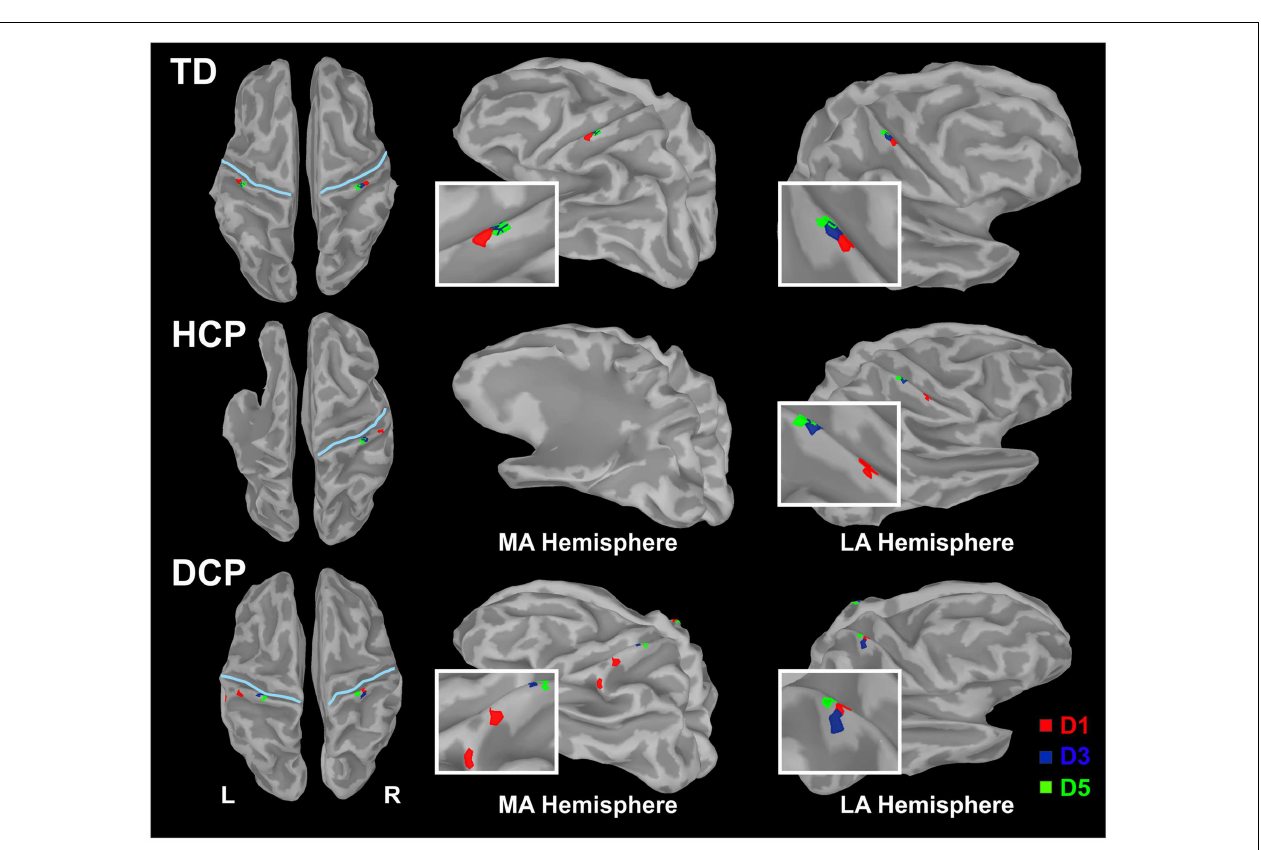
FIGURE 3 | Cortical responses in S1 at the peak of M50 for the tactile stimulation of D1, D3, and D5 of the right (left panel) and left (right panel) hands in the three representative participants (TD1, HCP1, and